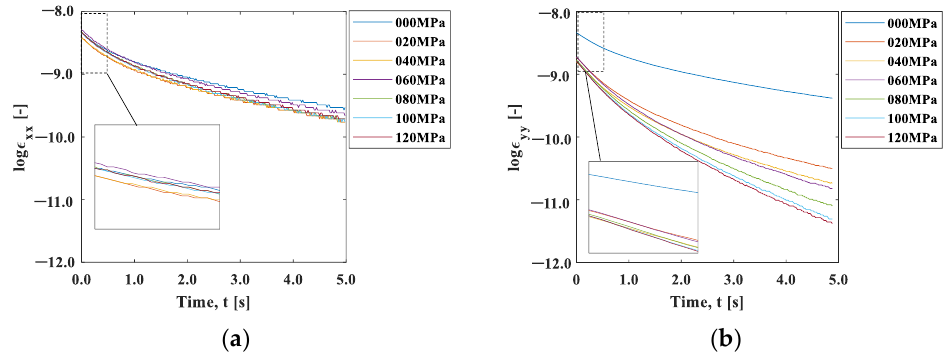
Figure 11. Log (strain) – time curve: ( a ) x-direction; and ( b ) y-direction. We evaluated this initial slope, called the coefficient of strain relaxation ( CSR ), by least squares fitting the natural logarithmic curve within 0.4 s in Figure 11. Figure 12a shows the results plotted as a function of the initial stress condition. The 𝐶𝑆𝑅 𝑦 decreased significantly with the initial stress, indicating that the relaxation occurred faster with the increase in the initial stress. In contrast, the CSR x showed a slight increase with the initial strain, indicating that the strain relaxation behavior was opposite to CSR y . The elastic modulus has stress dependency originating from the non-linearity and anharmonicity of the interatomic potential [18]. It is known that the elasticity decreases under tensile stress due to the fact that the slope of the potential curve decreases as the interatomic distance increases from its equilibrium position. It should be noted that the condition σ i = 0 is essentially different from the other initial stress conditions because one end of the specimen is under no constraint. The difference in the stress dependence between 𝐶𝑆𝑅 𝑥 and 𝐶𝑆𝑅 𝑥 observed in Figure 12a can be ascribed to Poisson’s effect. The tensile stress in the y -direction leads to the compressive stress in the x -direction. Figure 12b shows the aspect ratio, CSR x /CSR y . The aspect ratio under the initial stress 𝜎 = 0 MPa was about 1.4, indicating that larger shrinkage occurred in the 𝑥 -direction. 𝑖